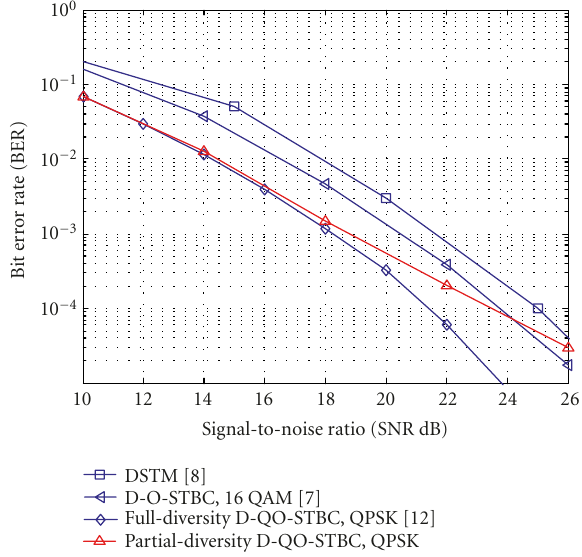
Figure 1: Di ff erential QO-STBC schemes at rate 2bps/Hz, four transmit